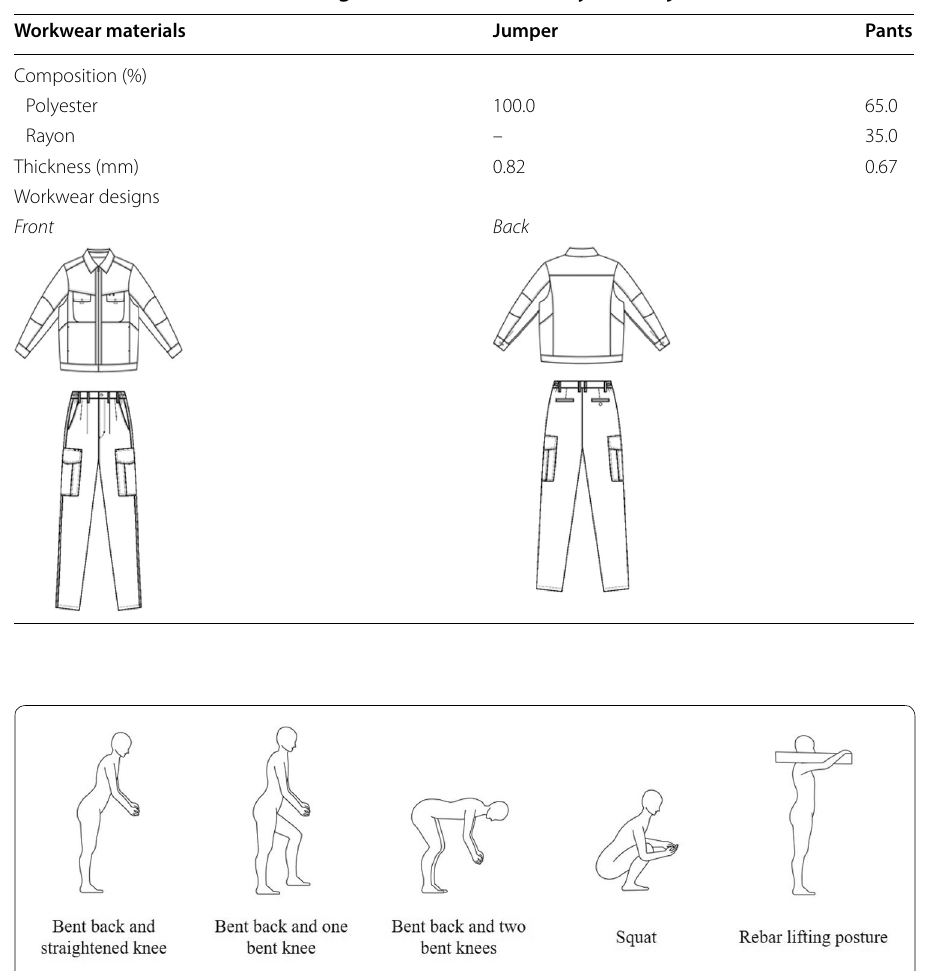
Fig. 1 Working postures for in‑depth